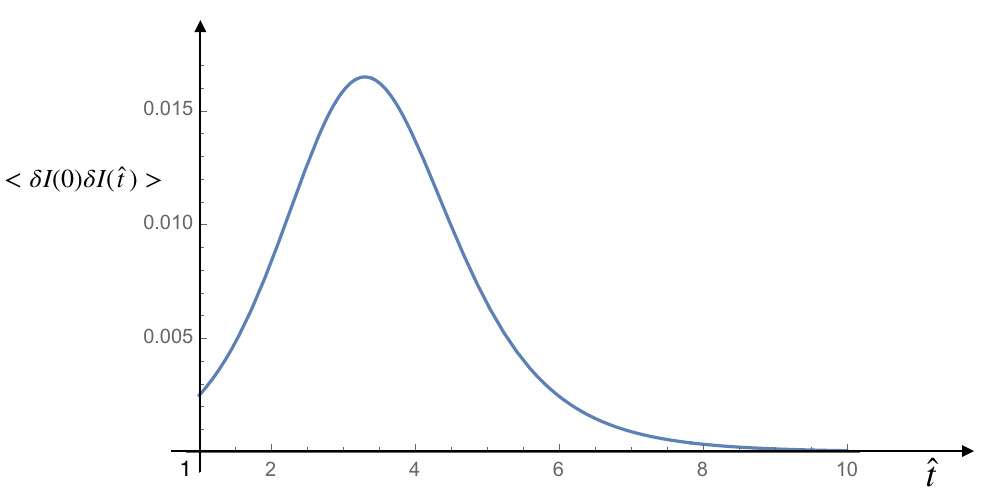
Figure 7. Correlation Function for Infectious people < δ I ( 1 ) δ ( ˆ t ) > . Plot of Equation (37) with I 0 = 5,000, K = 150,000, α = 1.5, and β = 0.1,